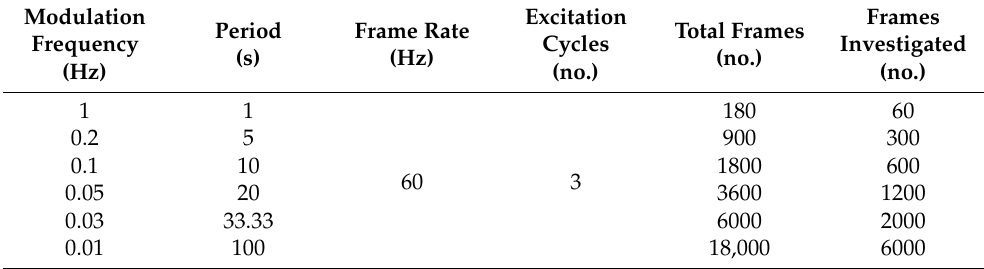
Table 3. Details of thermographic raw data to be processed by